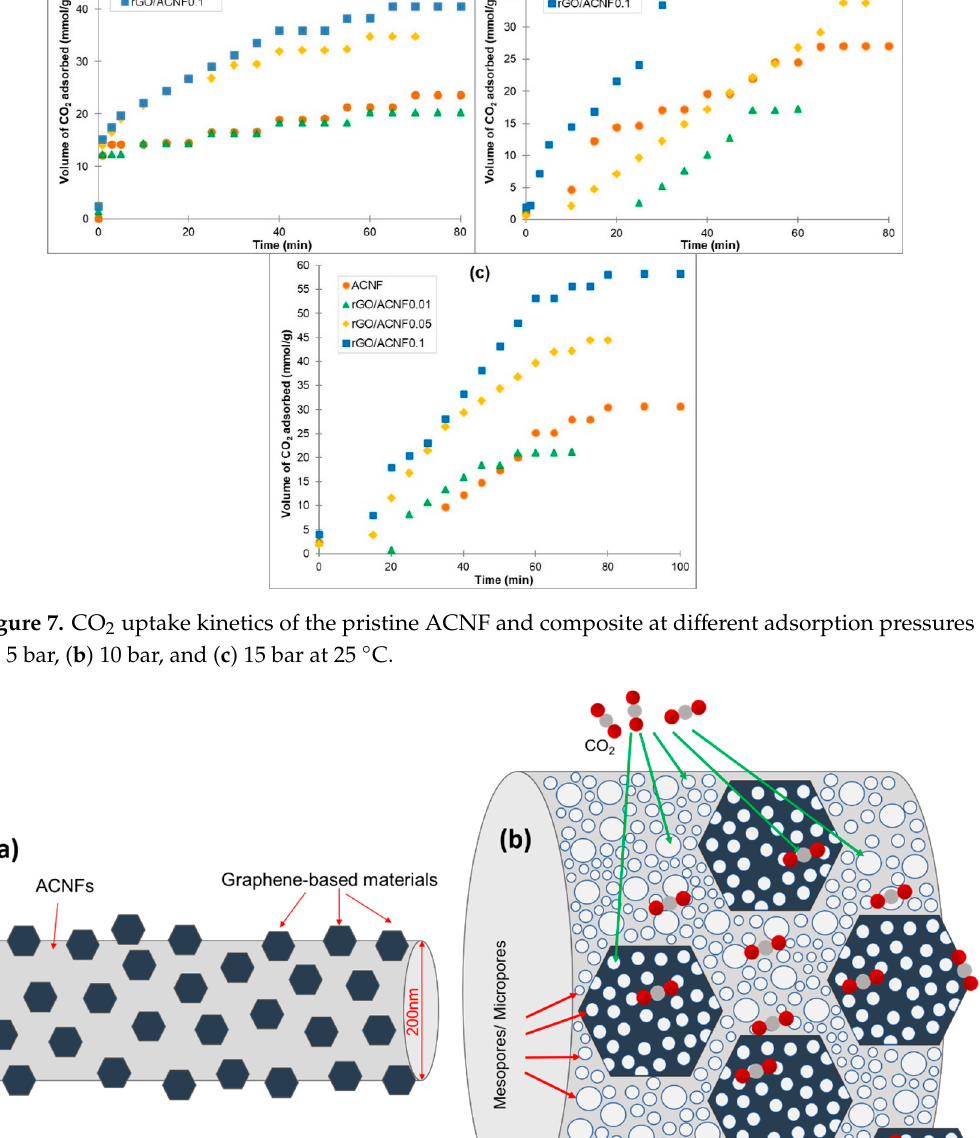
Table 3. Comparison of CO 2 adsorption capacity on various types of carbon fibers and their composite-based adsorbents.